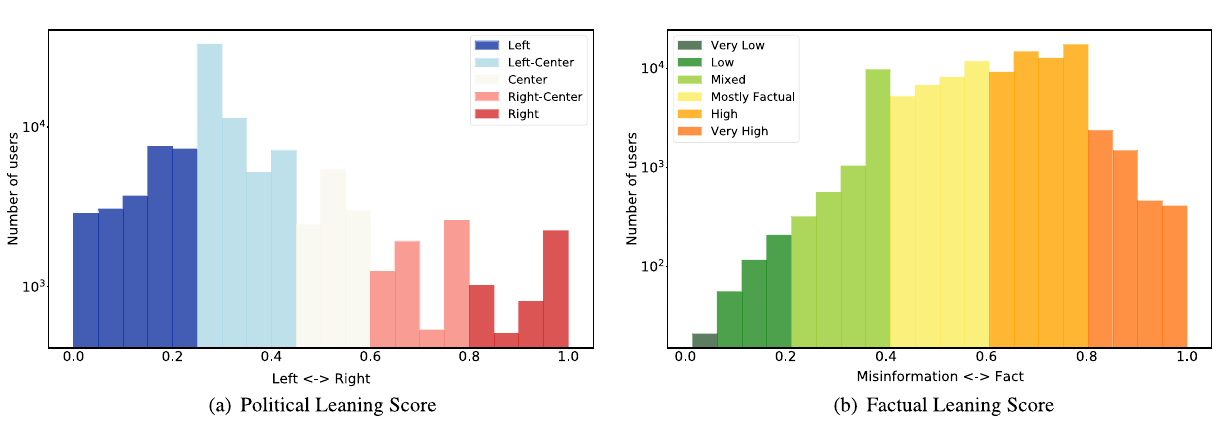
Figure 6. ( a ) Distribution of political leaning domain scores. ( b ) Distribution of factual leaning domain